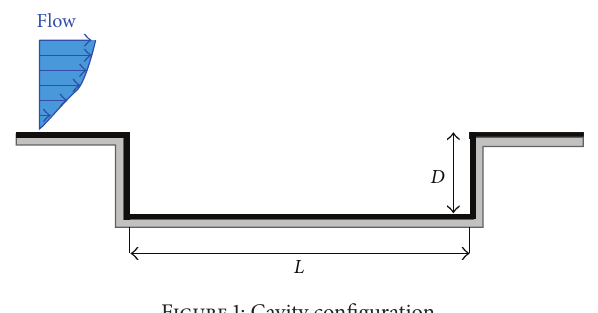
Figure 1: Cavity